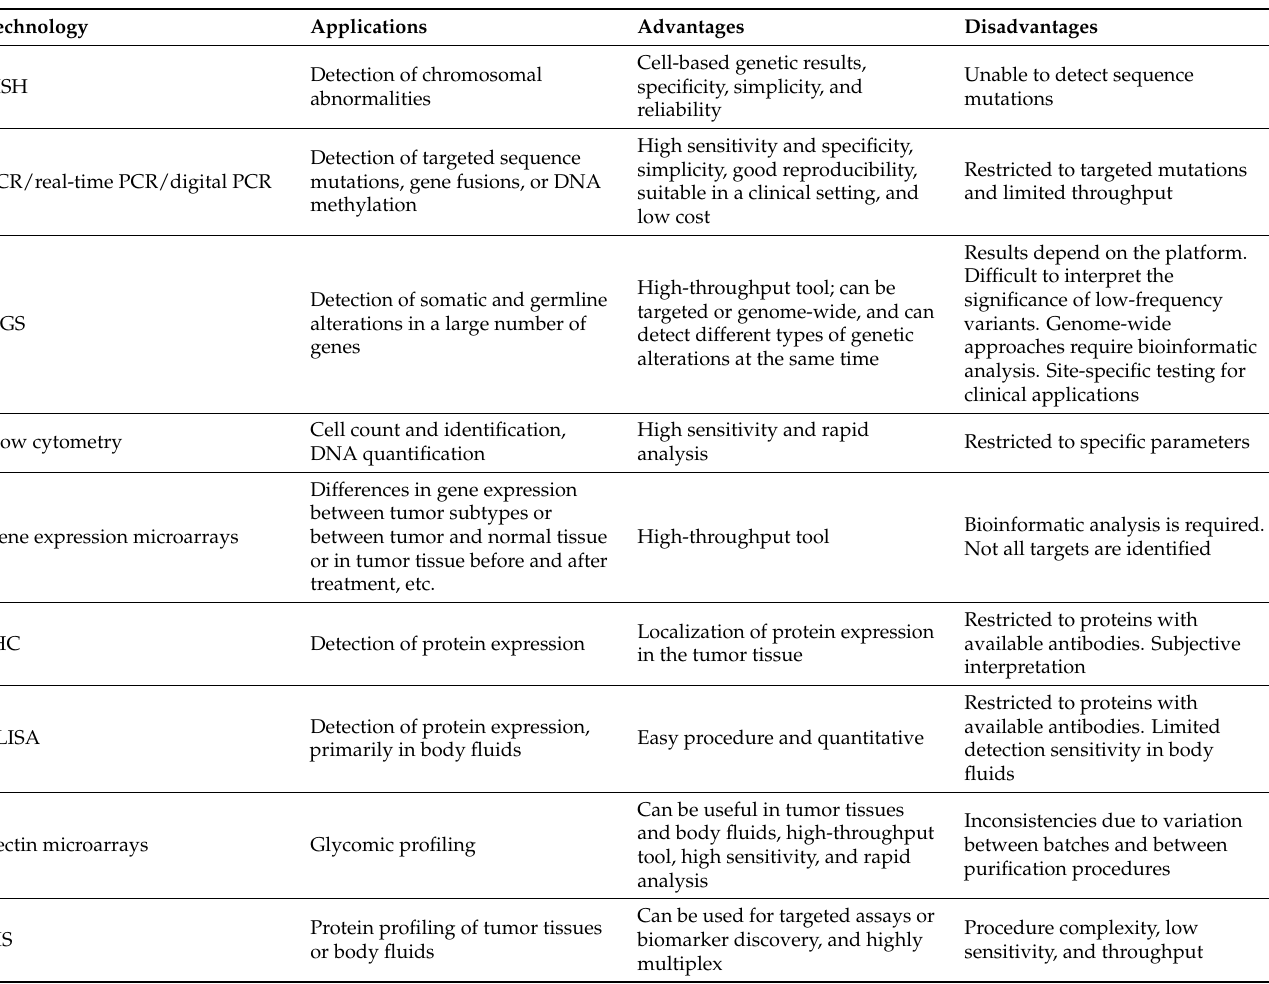
Table 3. List of technologies used for biomarker discovery and detection, and their applications, advantages, and